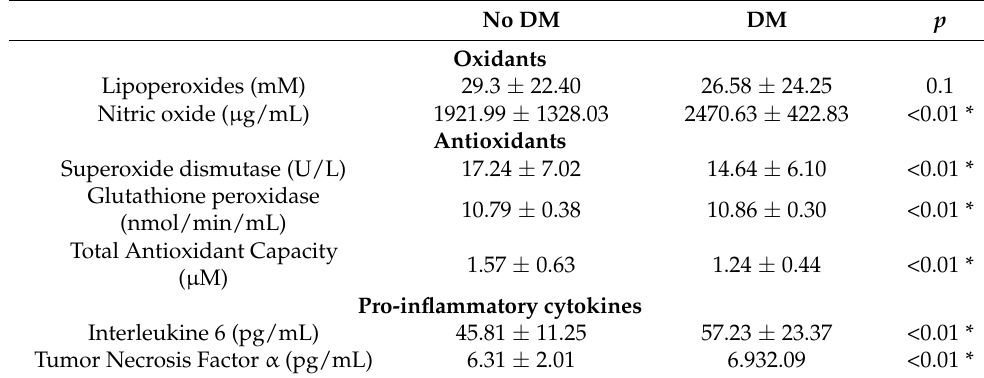
Table 3. Inflammatory and oxidative stress markers of patients with and without